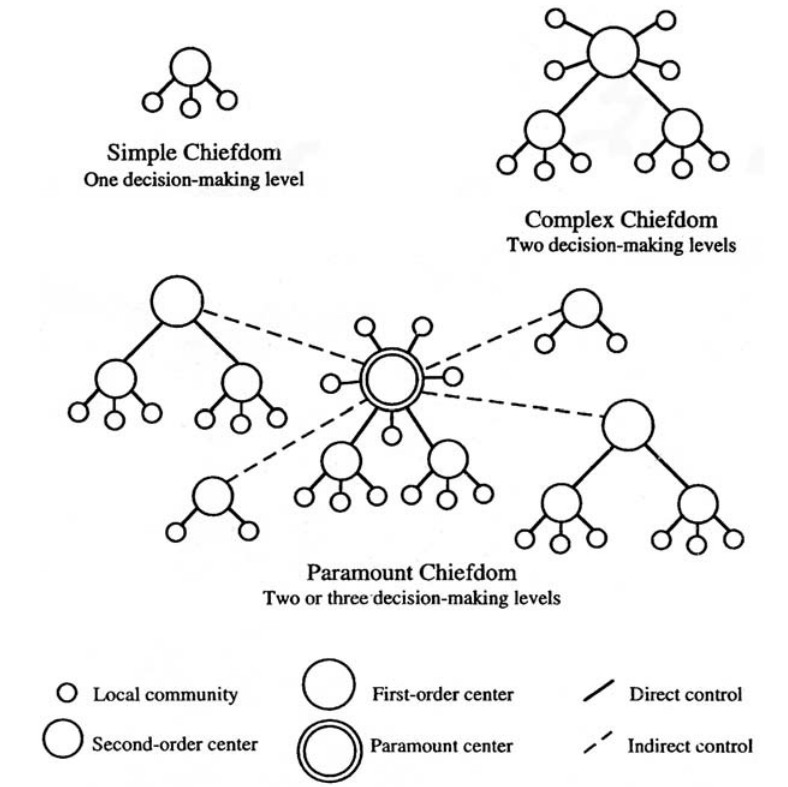
Figure 3 – Organization of Chiefdoms and Hierarchy of